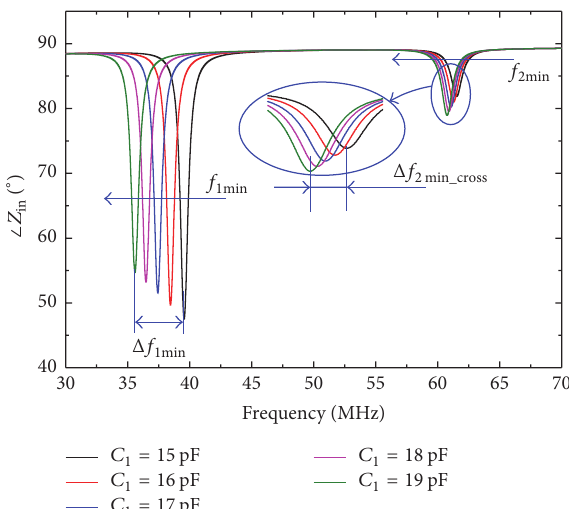
Figure 4: Schematic of the crosstalk of the dual-parameter passive